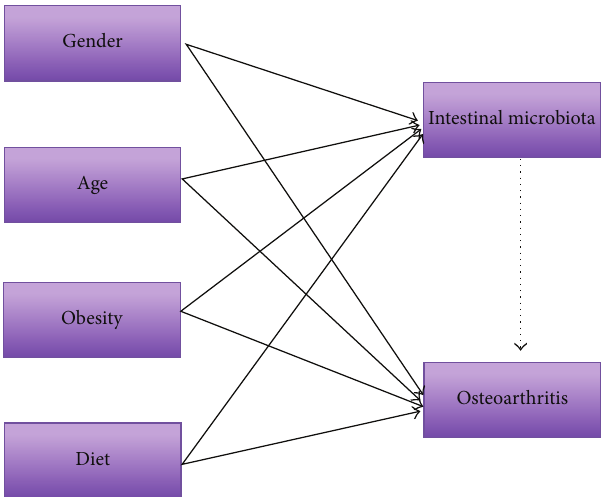
Figure 1: Intestinal microbiota in osteoarthritis (OA). Age, sex, obesity, and diet are risk factors in the etiology of OA (full line) and are associatedwiththealterationofintestinalmicrobiota(fullline).Thus,itispossiblethattheintestinalmicrobiotaisinvolvedinthepathogenesis of OA (dotted